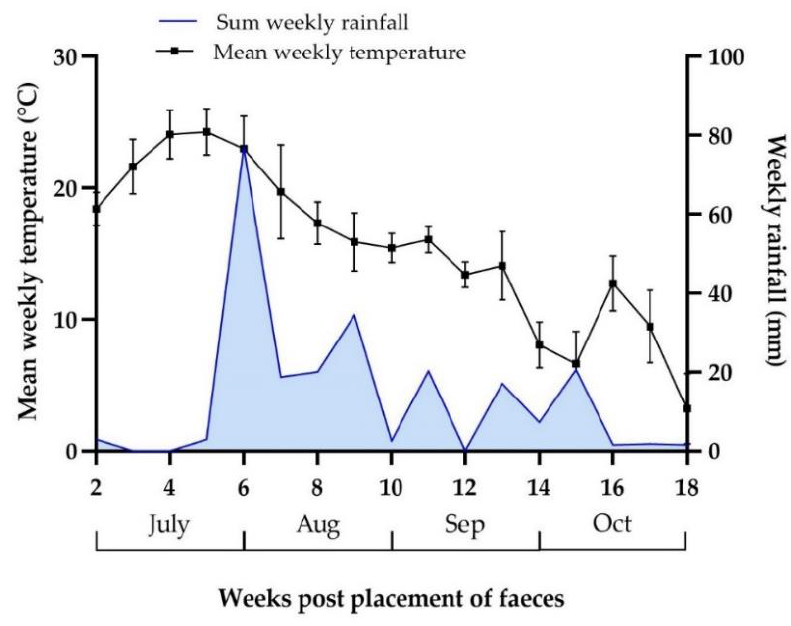
Figure 9. Weather data during the migration study, showing the mean (±SD) weekly temperature (°C) and the sum of weekly rainfall (mm).